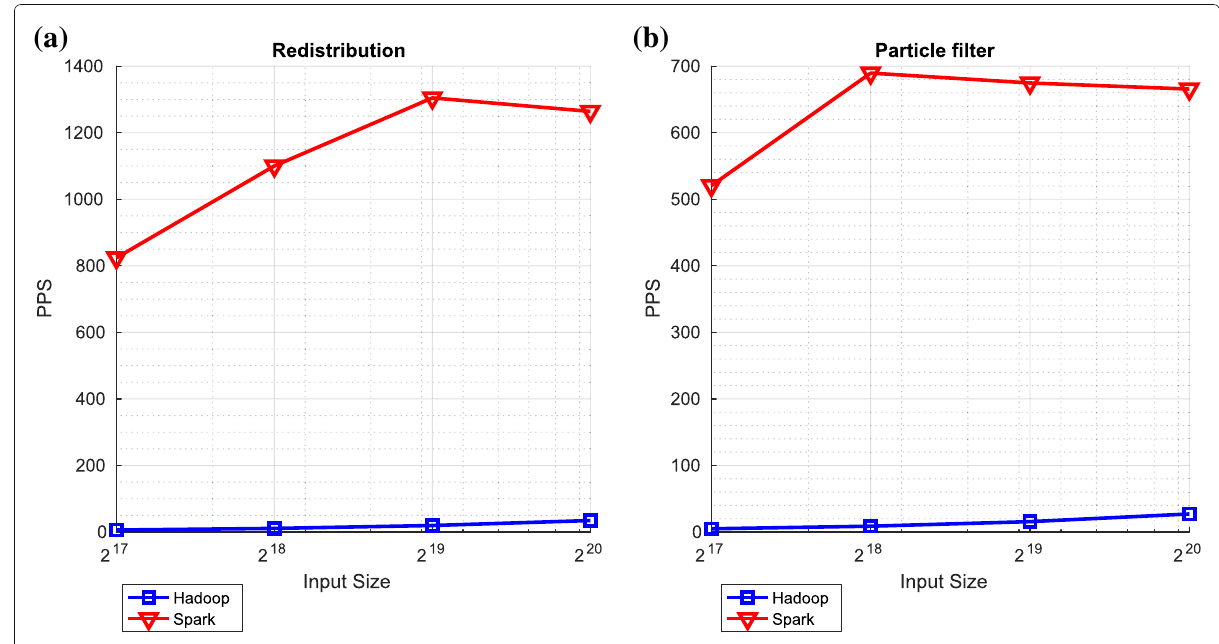
Fig. 11 Redistribution and the overall particle filtering on Spark and Hadoop. a Redistribution. b Overall particle